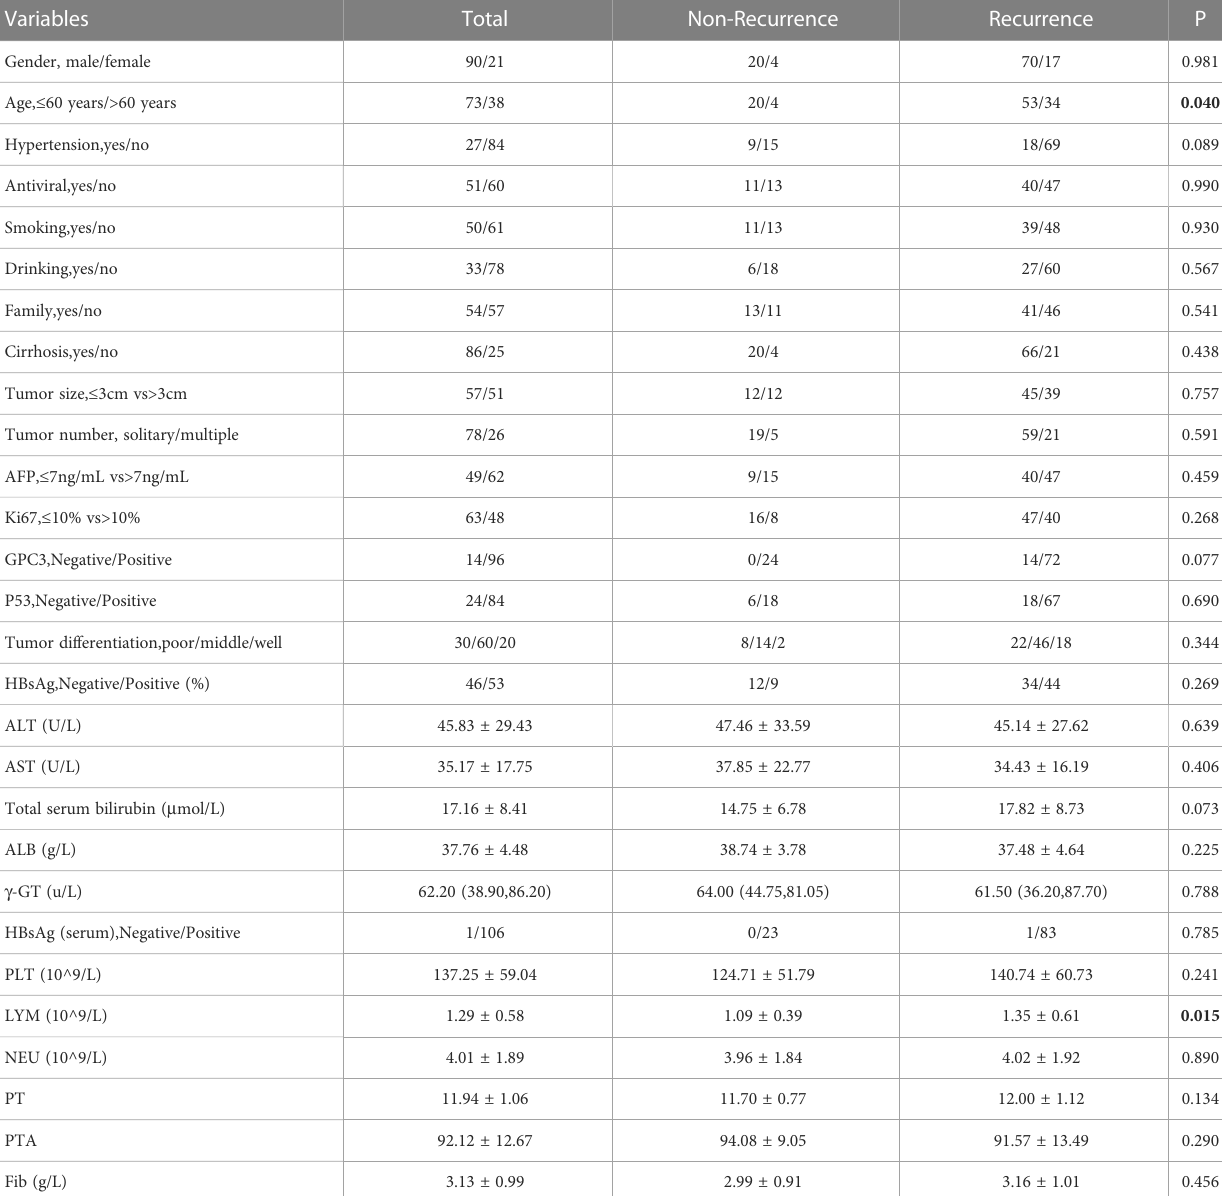
TABLE 1 Comparison of data between recurrent and non-recurrent HCC patients.